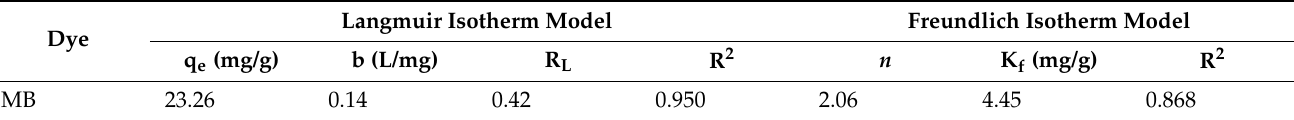
Table 2. Constants of Langmuir and Freundlich models for adsorption of MB-dye onto GO@CS composite